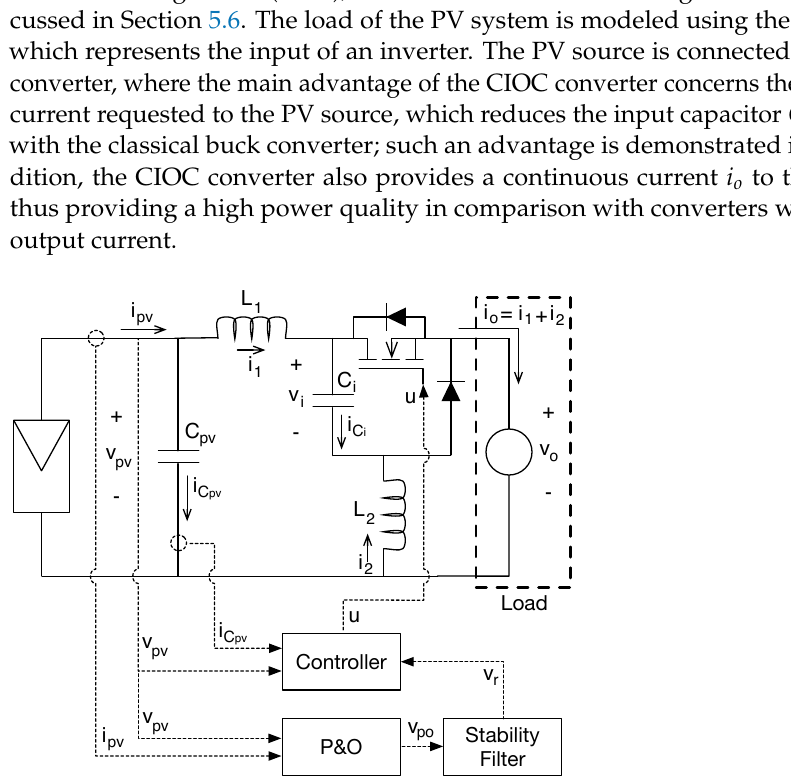
Figure 1. PV system based on the CIOC buck